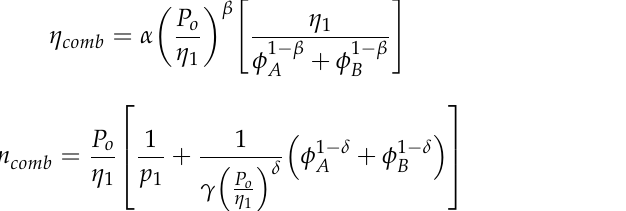
Figure 9. Combined system with non-constant efficiency and power.